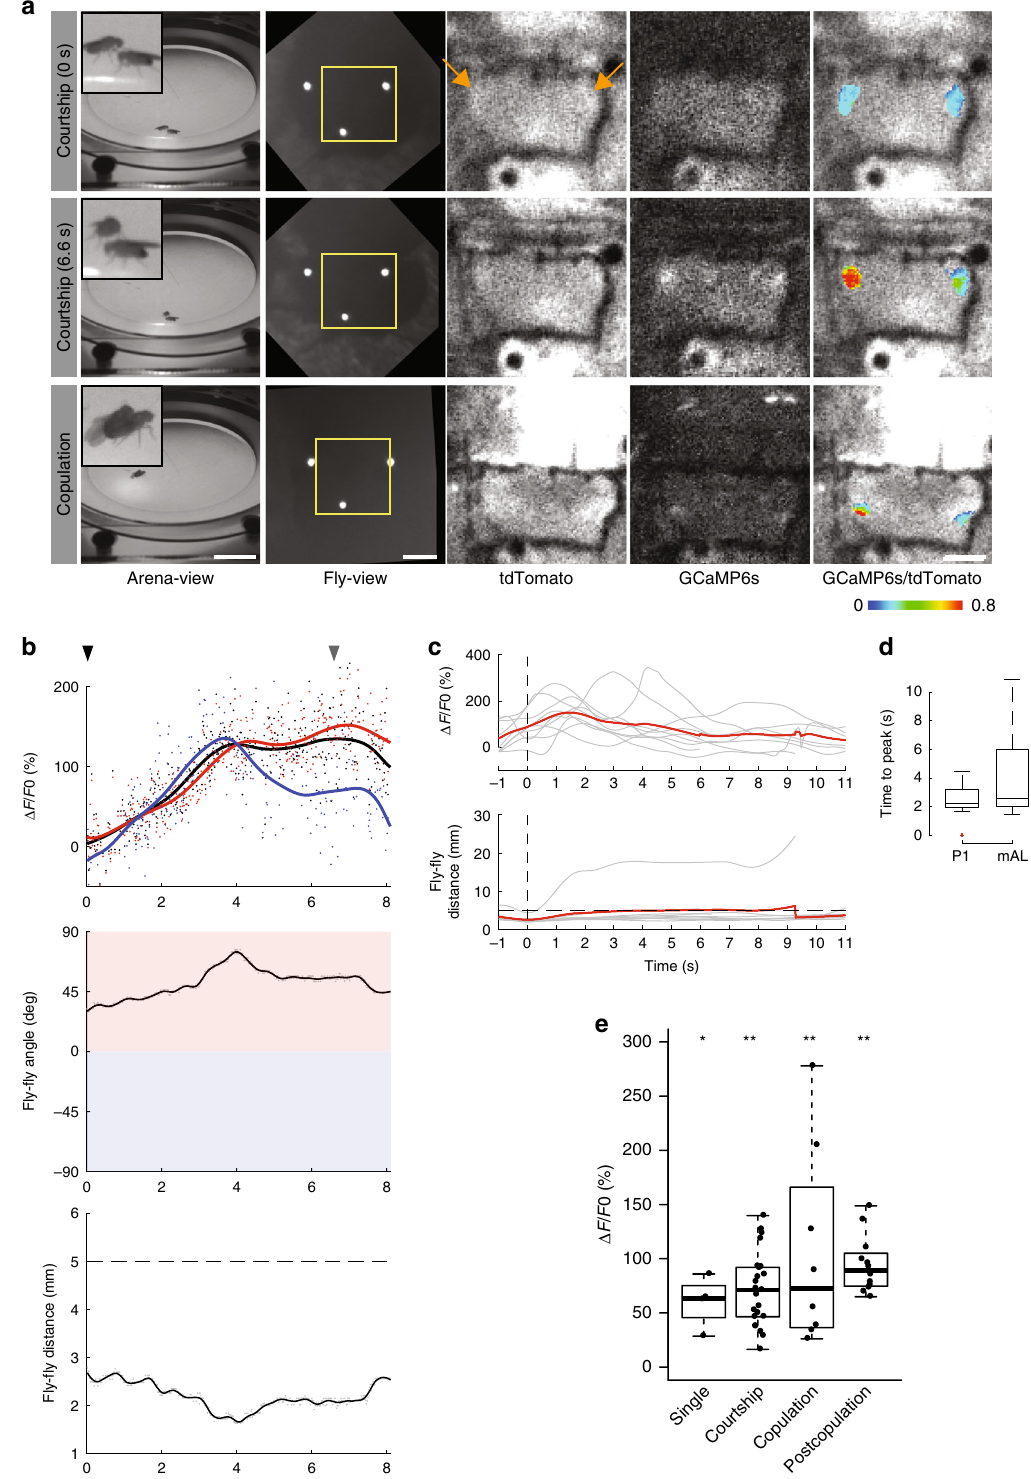
The following procedure was used to glue the beads to the diced coverslip windows. First, small amounts of UV glue (KOA-300, Poly-Lite) were placed at the three locations on the coverslip with an insect pin (Size 00, Fine Science Tools). Retrore fl ective beads, spread out on a glass slide, were then picked up individually with an insect pin using capillary action and then placed on the spots of glue on the coverslip. The orientation of the beads on the coverslip was critical for achieving good retrore fl ective properties. As the beads were hemispherically coated with aluminum, maximum retrore fl ection was achieved by placing the beads with